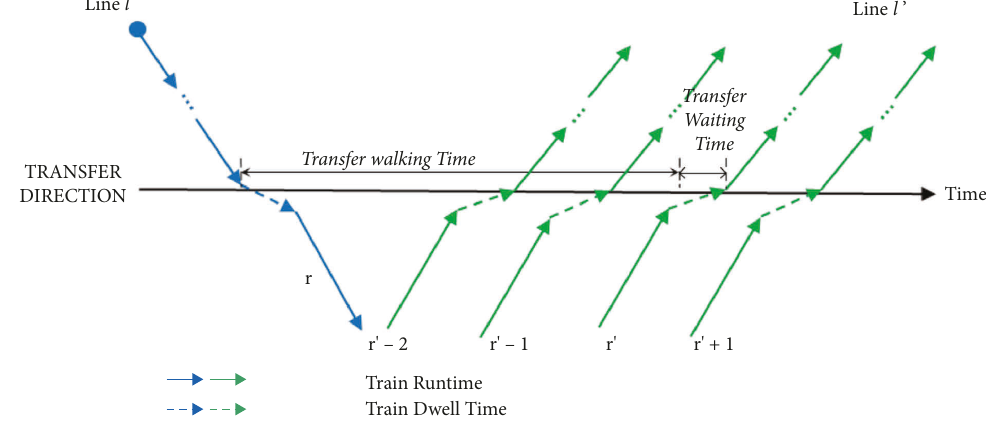
Figure 1: Schematic of the connection between different train operation Table 2: Objective functions and decision variables for different models.